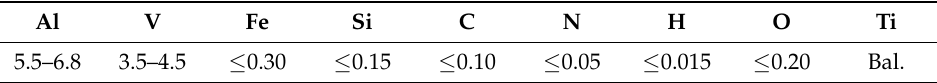
Table 1. Chemical composite of Ti6Al4V titanium alloy (wt